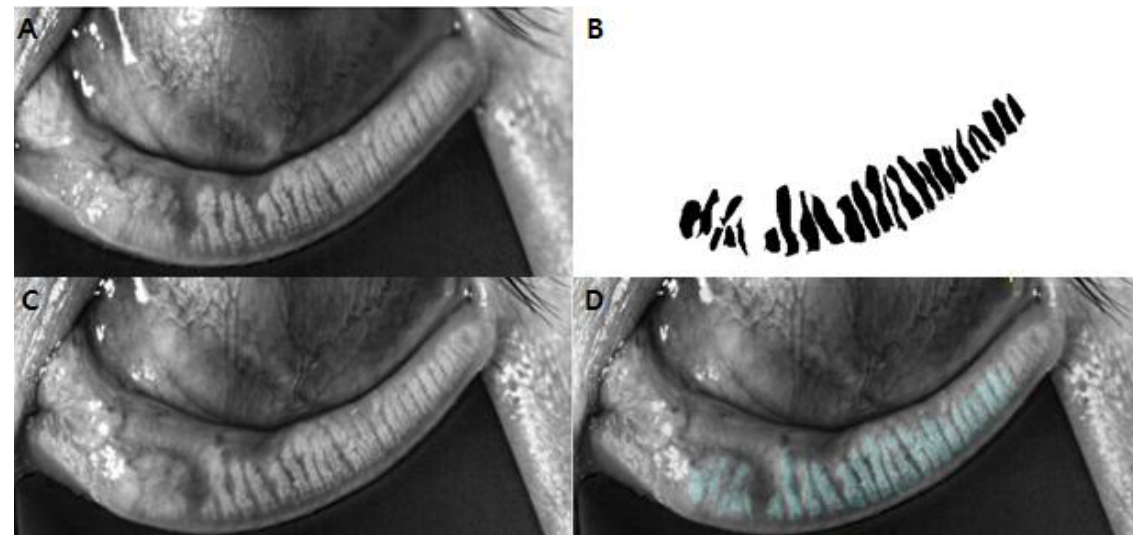
Figure 1. The representative example of overlaid, dynamic meibomian images (DMI) using Fiji. ( A ) Anonymized DMI of lower eyelid before mechanical expression. ( B ) Binary mask images con- structed from A, by manual delineation of each meibomian glands. ( C ) Anonymized DMI of lower eyelid after mechanical expression. ( D ) Overlay of the mask image of pre-expression ( B ) onto the post-expression DMI image ( C ).